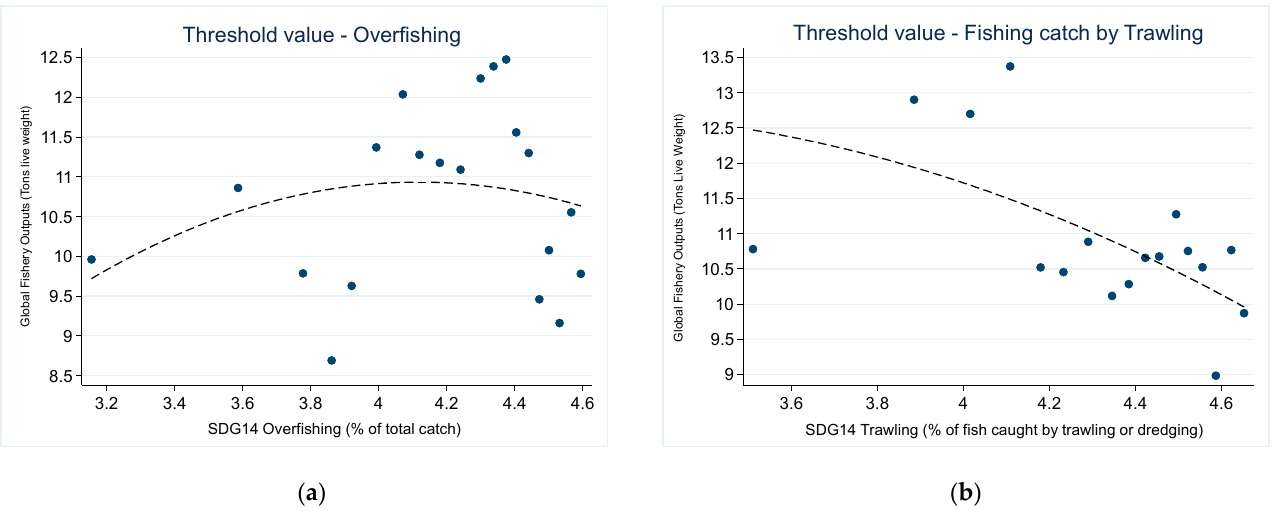
Figure 2. The nonlinear effects of overfishing (SDG14 overfishing) and fish catch by trawling (SDG14 trawling) on global fishing outputs. ( a ) Threshold value of overfishing; ( b ) threshold value of catching fish by trawling or dredging.